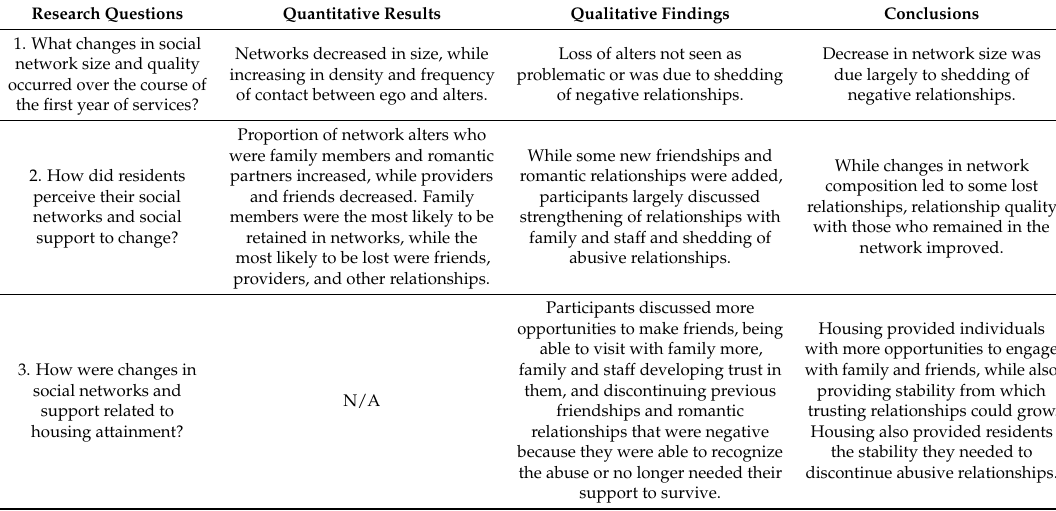
Table 4. Comparison of quantitative results and qualitative